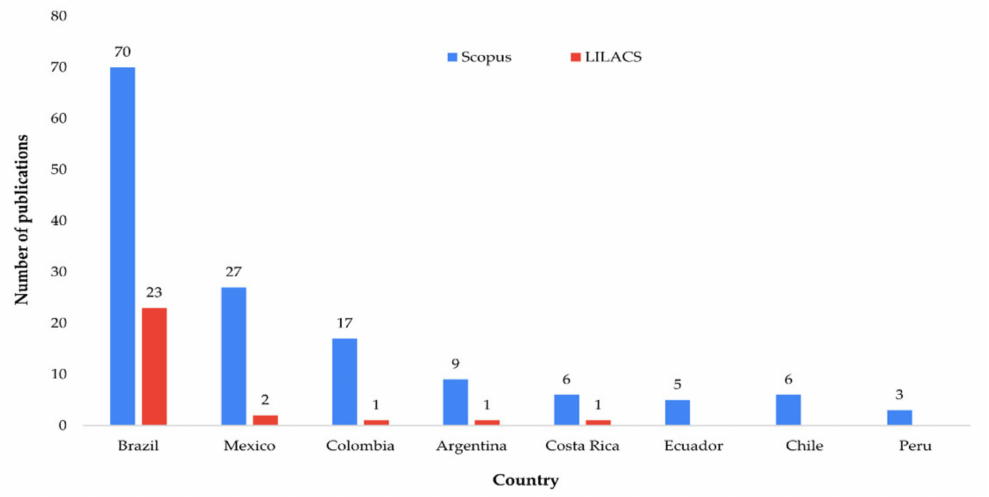
Figure 2. Number of publications indexed in Scopus and LILACS by